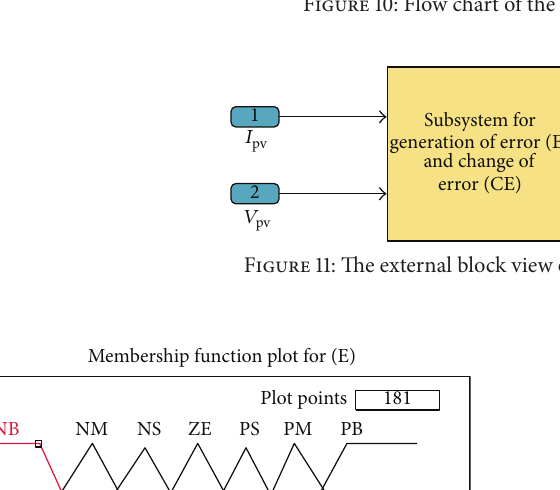
Figure 10: Flow chart of the fuzzy logic algorithm.